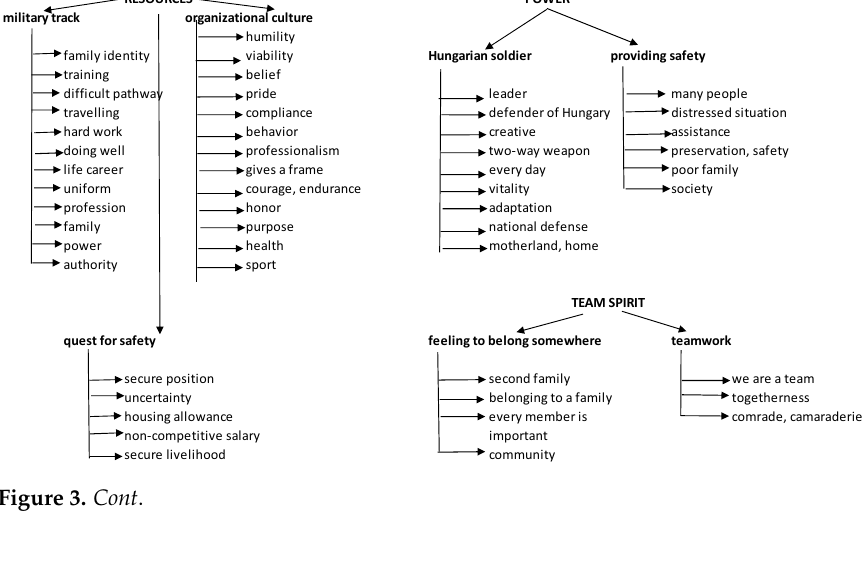
Figure 3. Selective codes and the terms belonging to them.